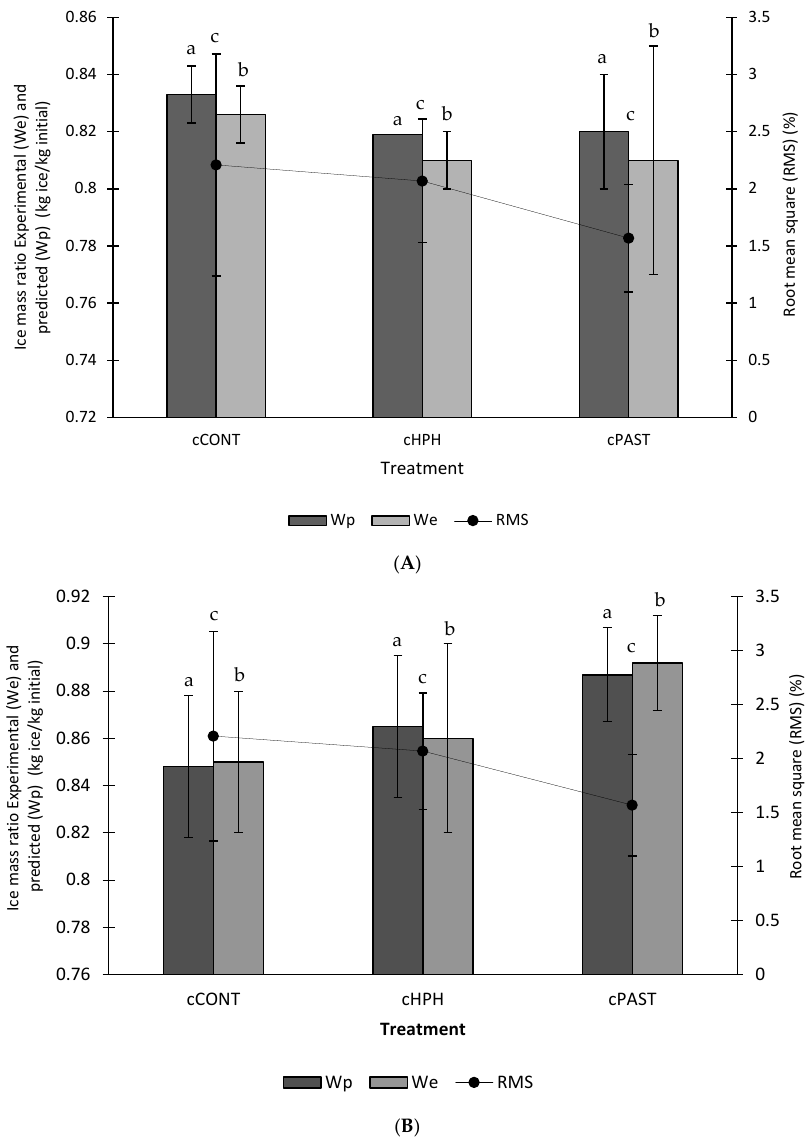
Figure 2. Validation of results obtained in the cryoconcentration process of aqueous maqui ( A ) and calafate ( B ) extracts. cCONT, cryoconcentrate control; cHPH cryoconcentrate previously treated by high‒pressure homogenization; cPAST, cryoconcentrate previously treated by pasteurization. Different letters (a–c) for the same variable indicate significant dif- ferences between the means of the different treatments ( p ≤ 0.05).